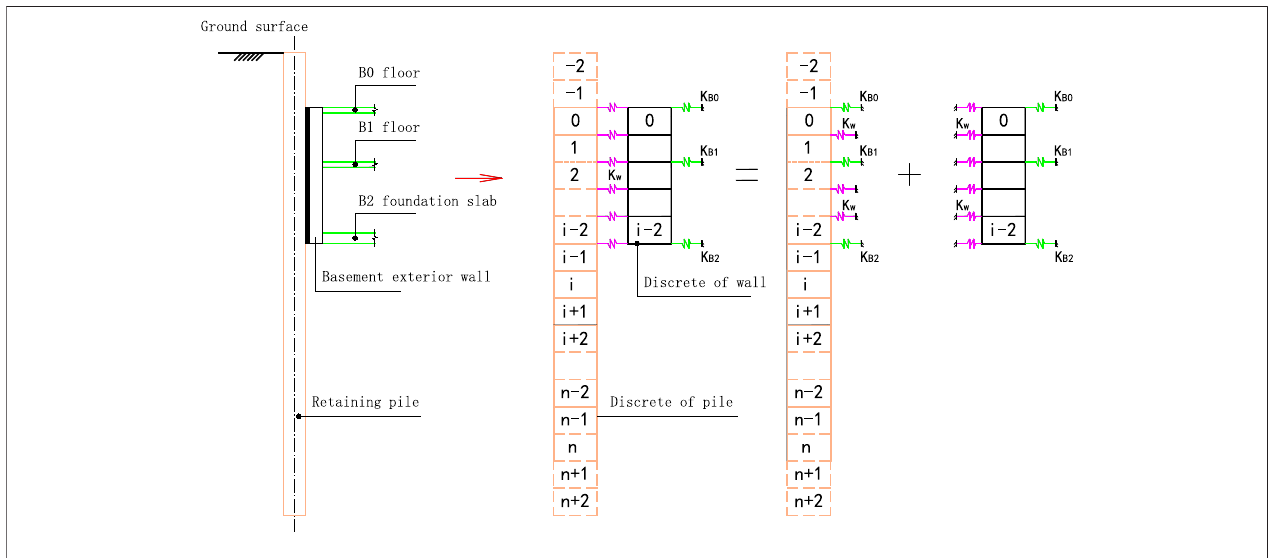
FIGURE 3 | Discrete analysis of the pile wall combination